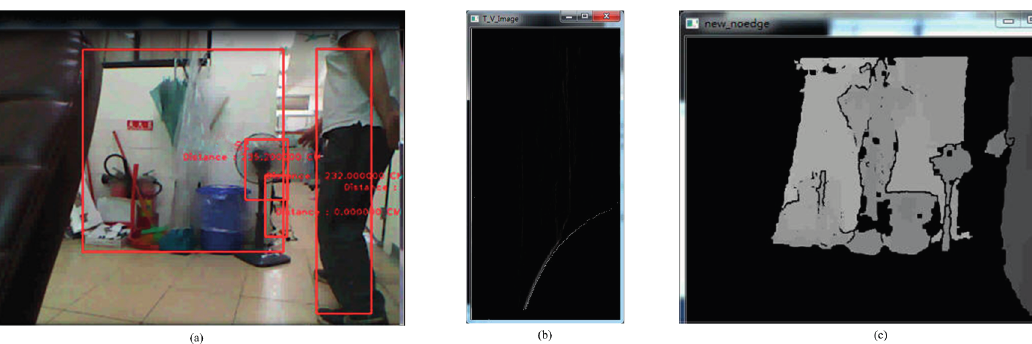
Figure 7. The scene without people. ( a ) Real scene; ( b ) V-disparity; ( c ) Depth map.